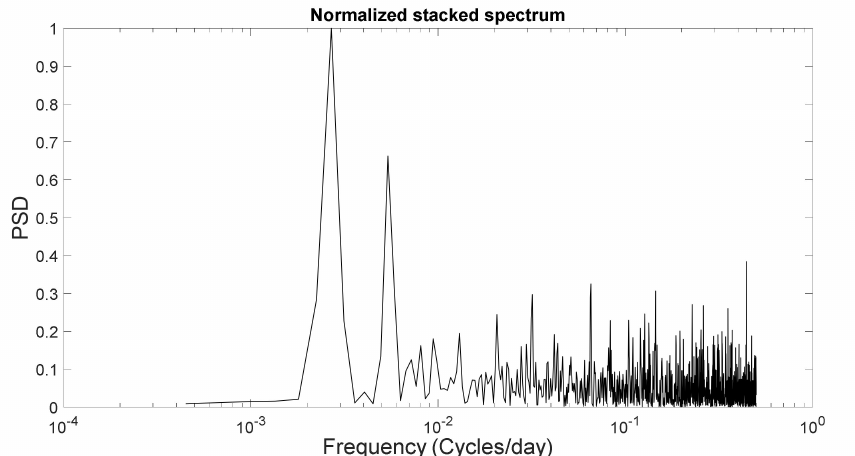
Figure 2. Normalized power spectrum (PSD) in semilogarithmic scale stacked over the 200 series of aerosol optical depth (AOD): A dominant peak is associated with the annual cycle, but also higher harmonics are evident up to a week